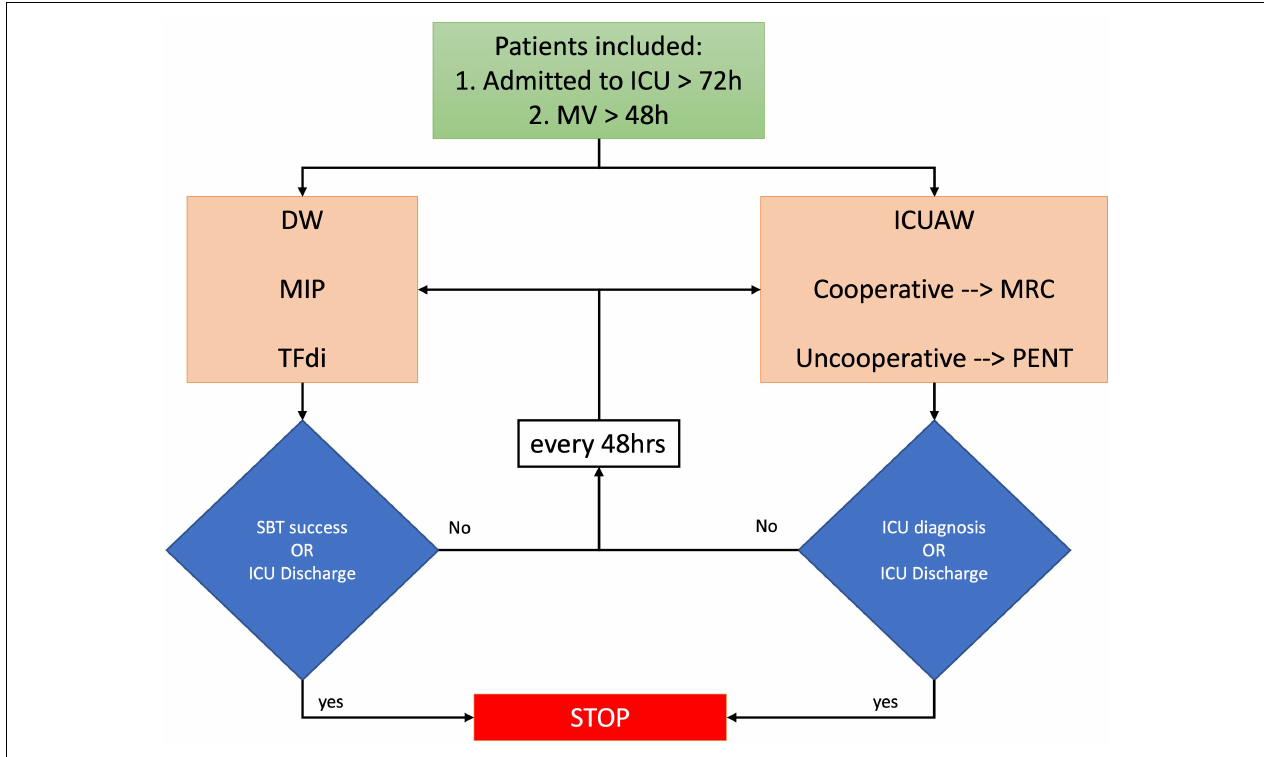
FIGURE 1 | Study protocol. Patients admitted to intensive care medicine (ICU) for > 72 h and mechanically ventilated for > 48 h were screened. ICUAW was evaluated using MRC and PENT, and DW was diagnosed with MIP and TFdi. MV, mechanical ventilation; TFdi, diaphragm thickening fraction; MIP, maximal inspiratory pressure; MRC, medical research council scale; PENT, simplified peroneal nerve test; SBT, spontaneous breathing trial (PSV 6/6 cmH2O).